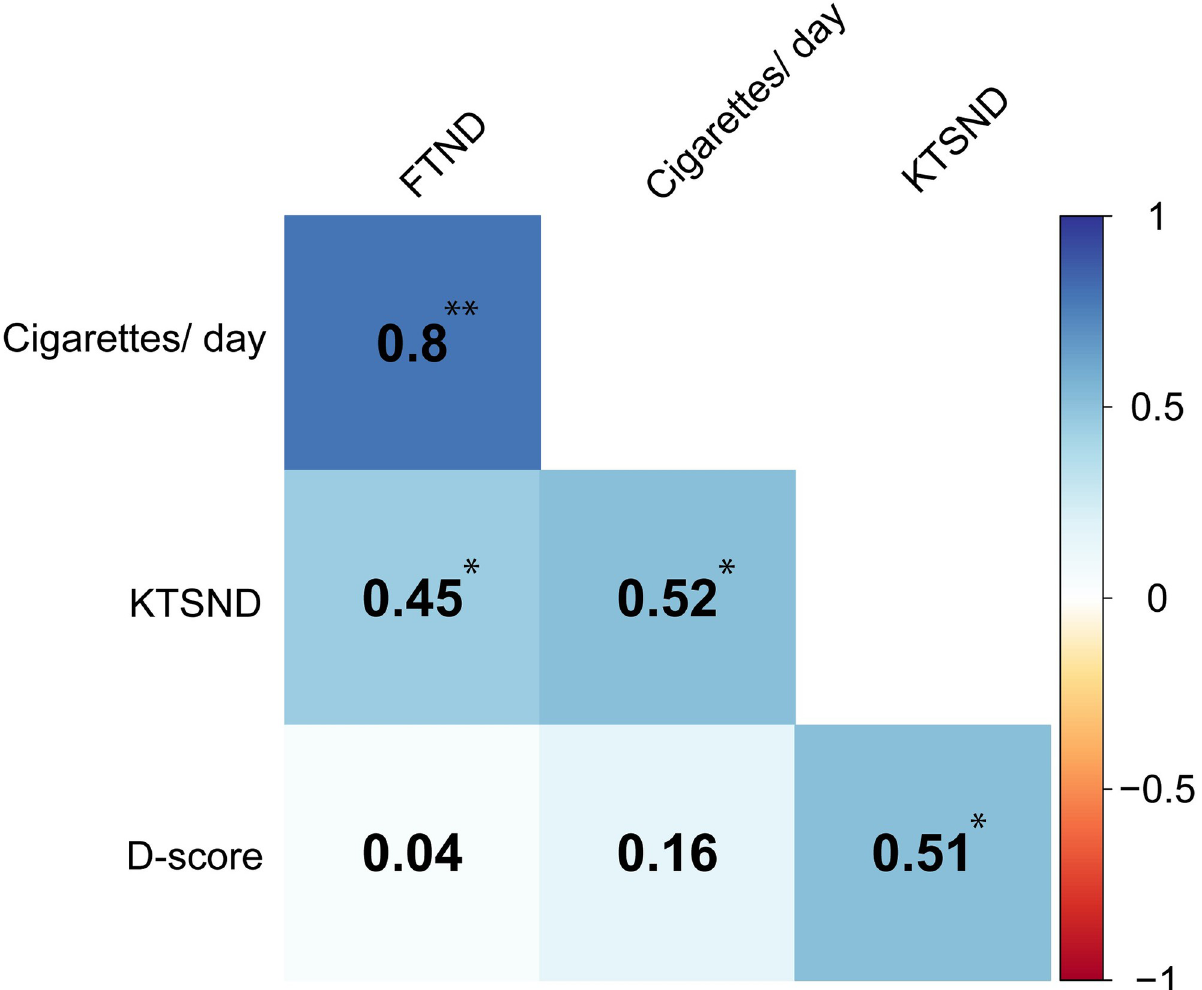
Fig 3. Correlation analysis among the smoking-related measures. All p-values were corrected with FDR correction. FTND: Fagerstrom Test for Nicotine Dependence, KTSND: Kano Test for Social Nicotine Dependence. � q < .05, �� q < .01.